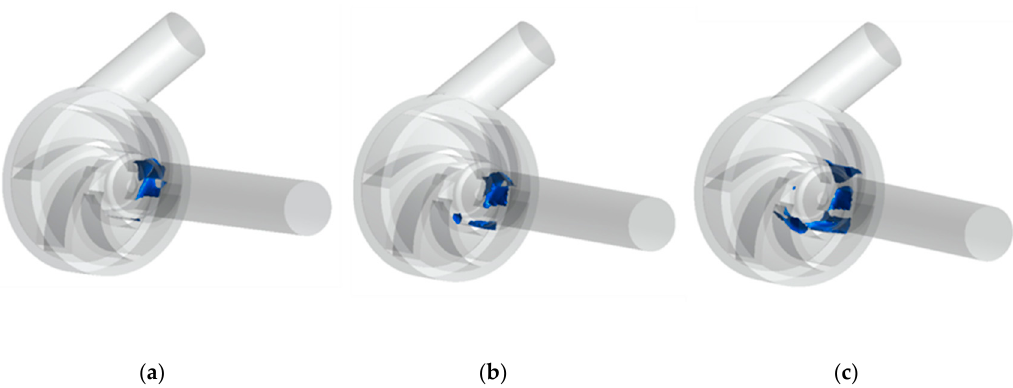
Figure 11. Cavitation bubbles in pump impellers at di ff erent speeds: ( a ) ω = 2330 r / min; ( b ) ω = 3330 r / min; ( c ) ω = 4330 r / min.